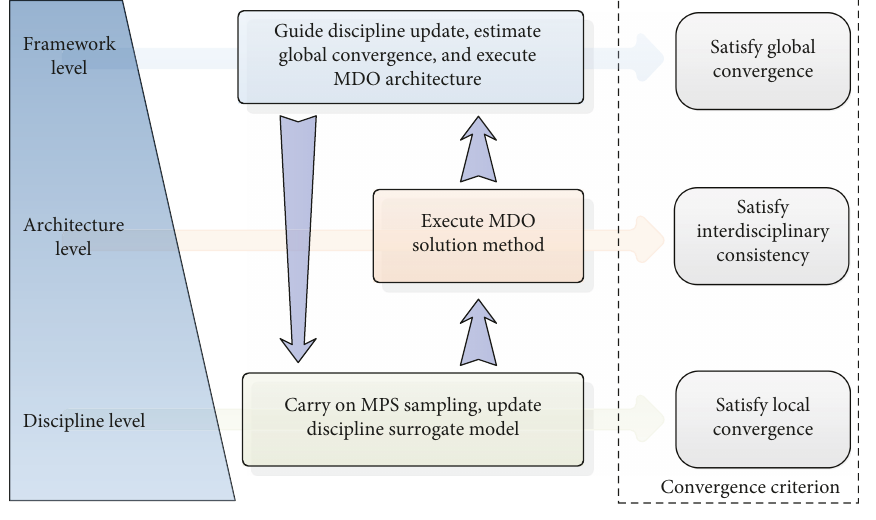
Figure 2: Design skeleton of the MDO